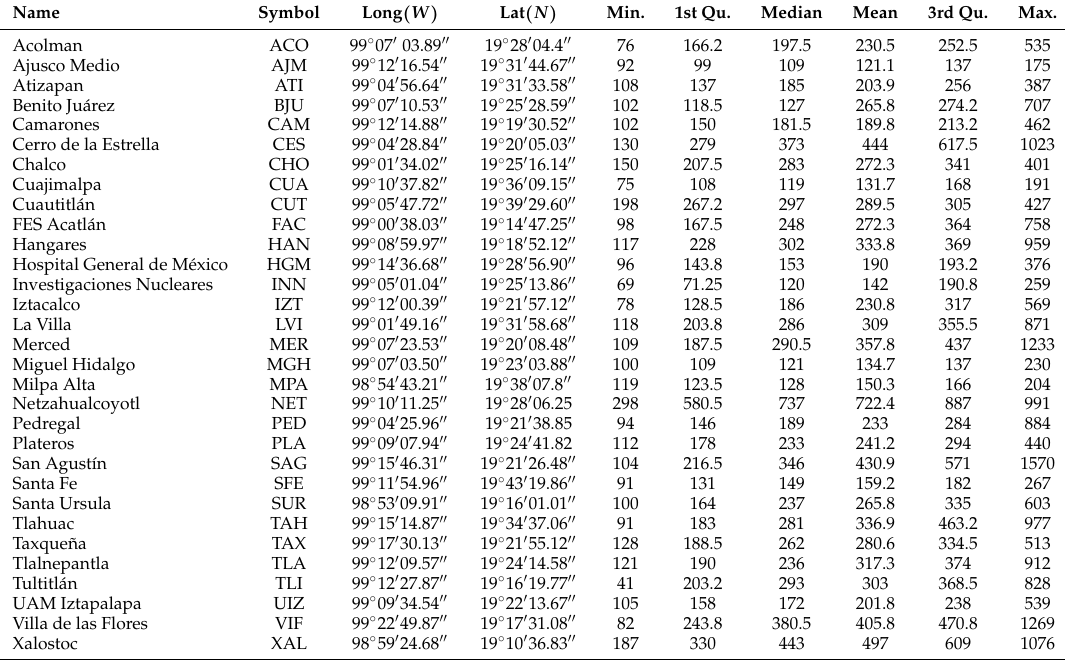
Table 1. Descriptive summary information on the extreme values of particulate matter less than 10 micrograms in diameter (PM 10 ) at the stations considered in the